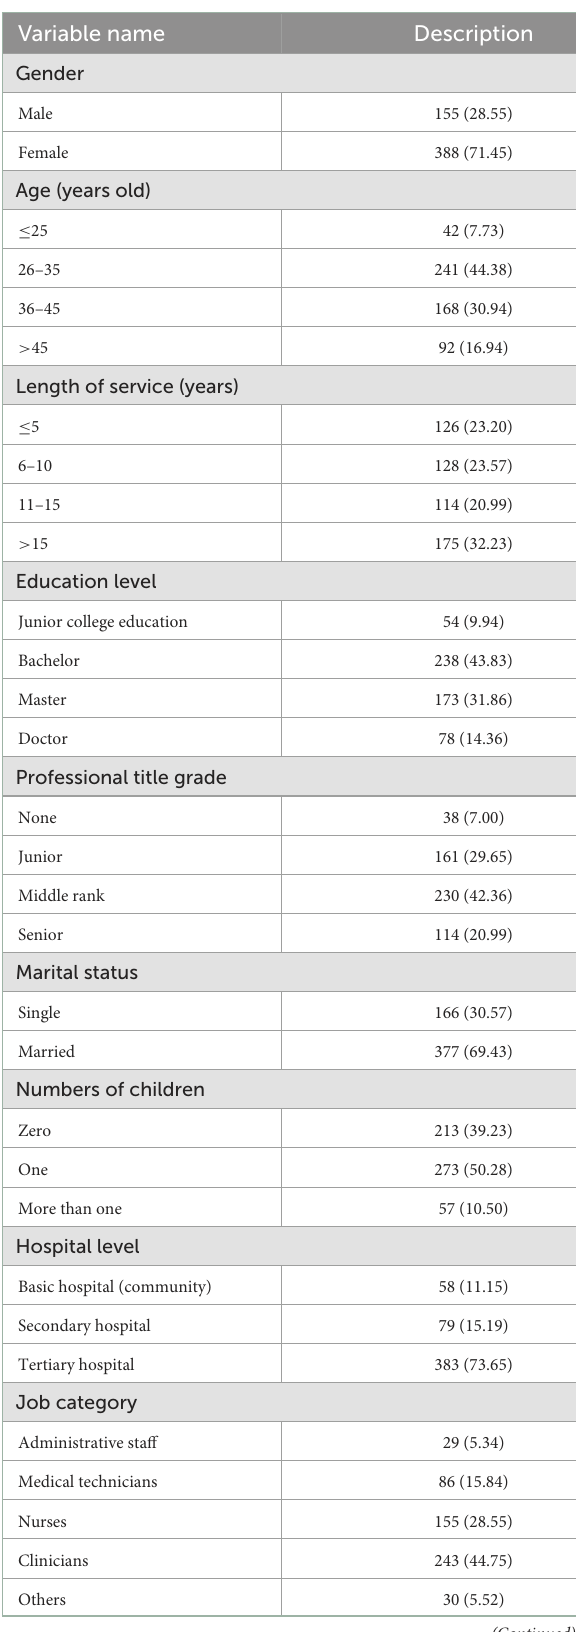
TABLE 2 Demographic data of participants ( n =